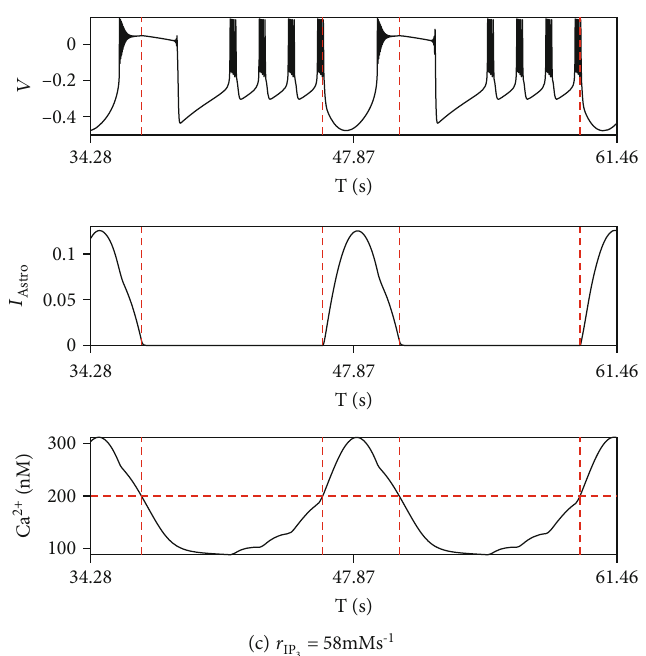
Figure 4: Membrane potential compared with feedback current and Ca 2+ activities in (a) Ca 2+ is under threshold ð r oscillates across threshold ð r = 50mMs ‐ 1 Þ , and (c) Ca 2+ oscillates above the threshold ð r IP 3